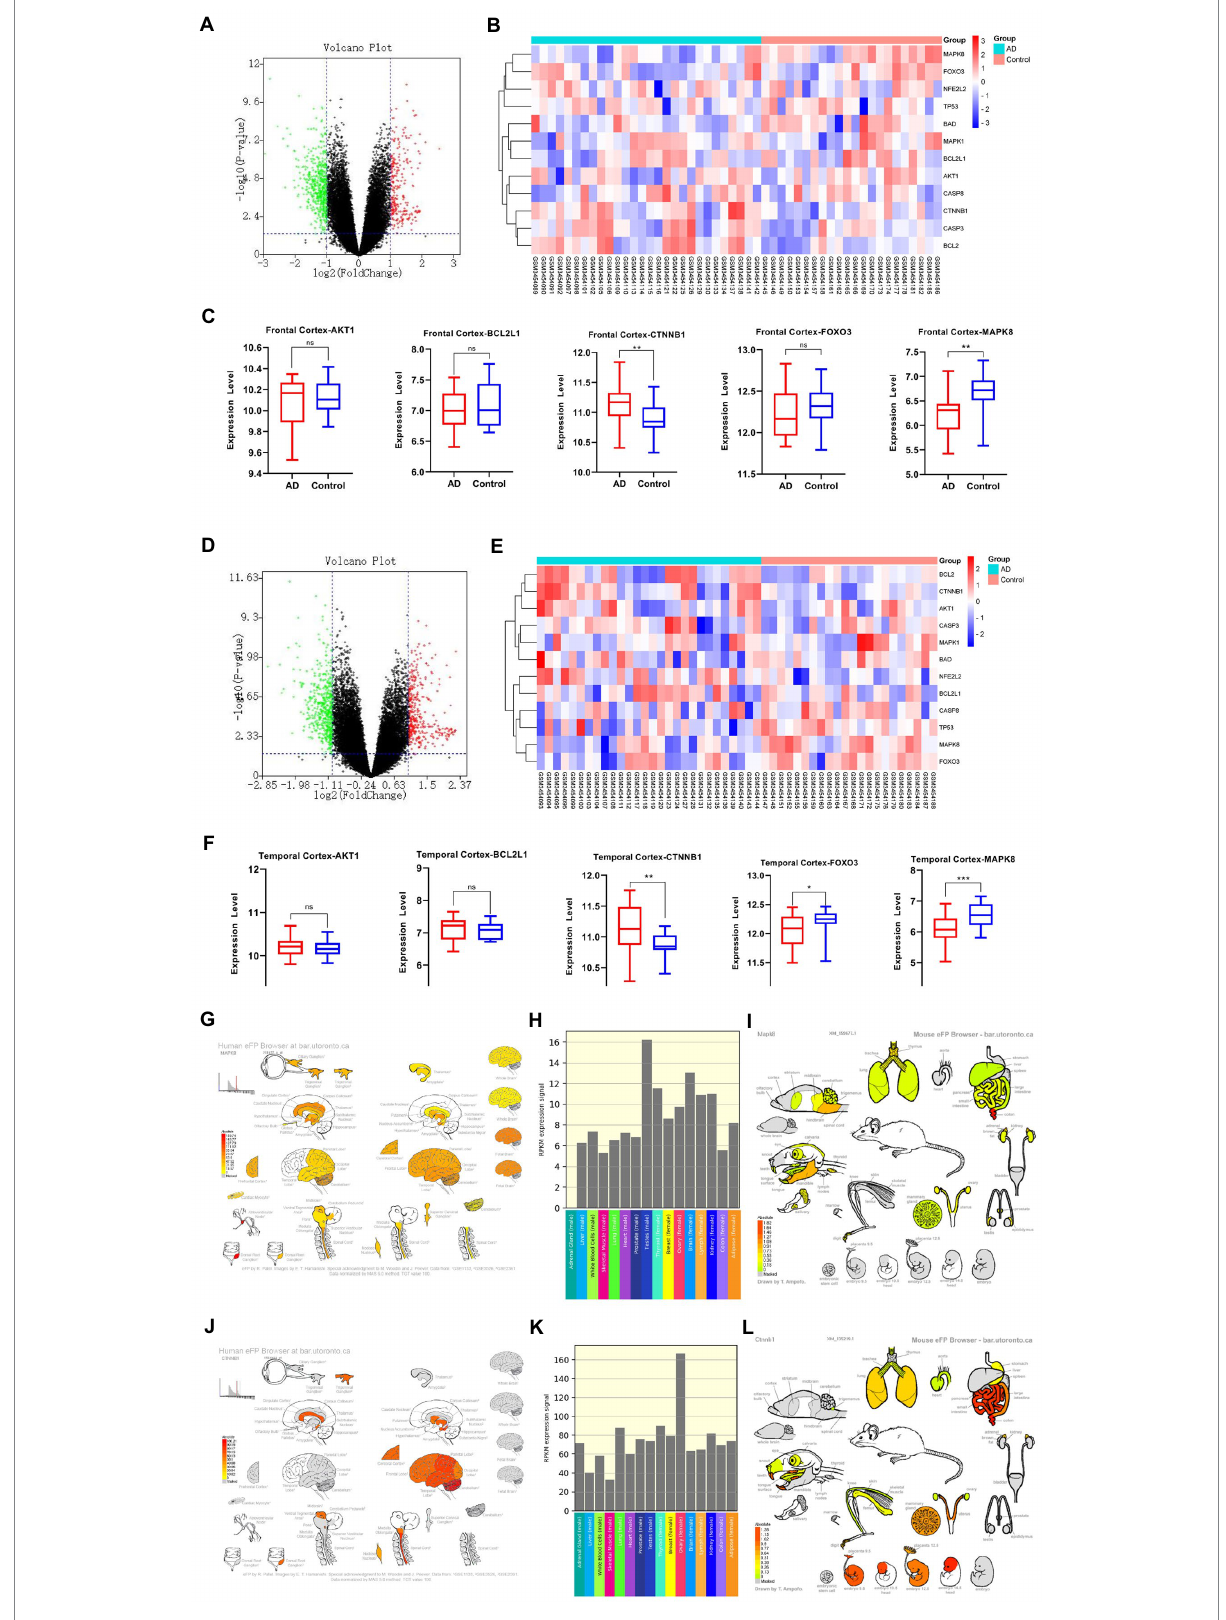
FIGURE 9 AD mRNA Expression analysis using GEO Dataset (A,C,D,F) . Composition-Target binding energy heat map (B,E) . MAPK8 expression analysis in the regular human nervous system (G,H) . MAPK8 expression analysis in tissues and organs of a normal mouse (I) . CTNNB1 expression in the normal human nervous system (J,K) . CTNNB1 expression analysis in tissues and organs of normal mouse (L) . * p < 0.05, ** p <